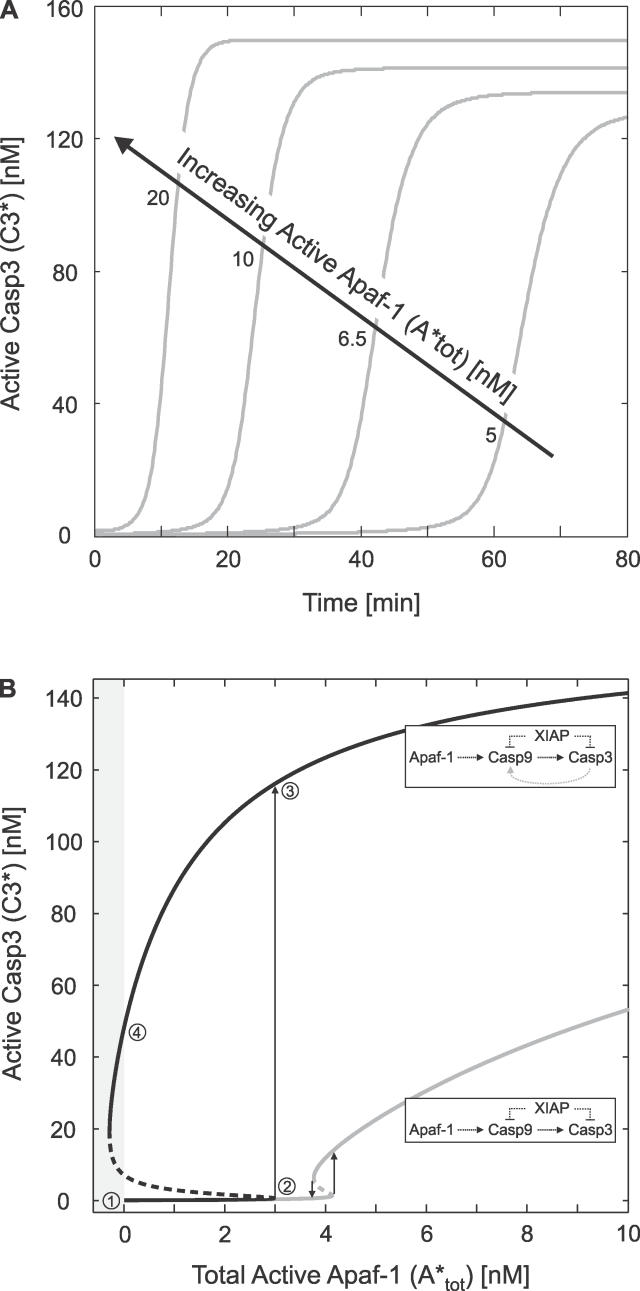
Dynamic and Steady-State Behaviour of the Caspase Cascade(A) Time course of Casp3 activation (wild-type model) upon a step-like increase in the amount of active Apaf-1 (A*tot) at t = 0 from zero to the concentration indicated.(B) Steady-state stimulus-response curves of the wild-type model (black line) and of the Casp9-mutant model (gray line), where Casp3-mediated feedback cleavage of Casp9 does not occur. Stable and unstable steady states are indicated by solid and dashed lines, respectively.